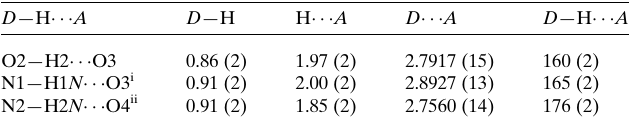
Table 2 Hydrogen-bond geometry (A˚ , (cid:3) ) for